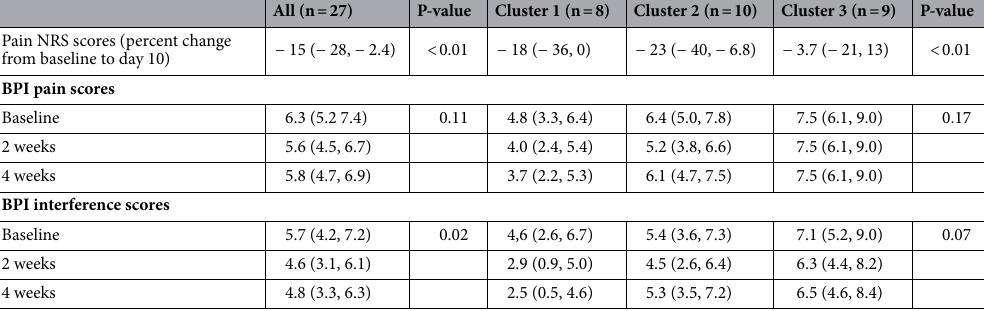
Table 2. Efficacy of scrambler therapy.